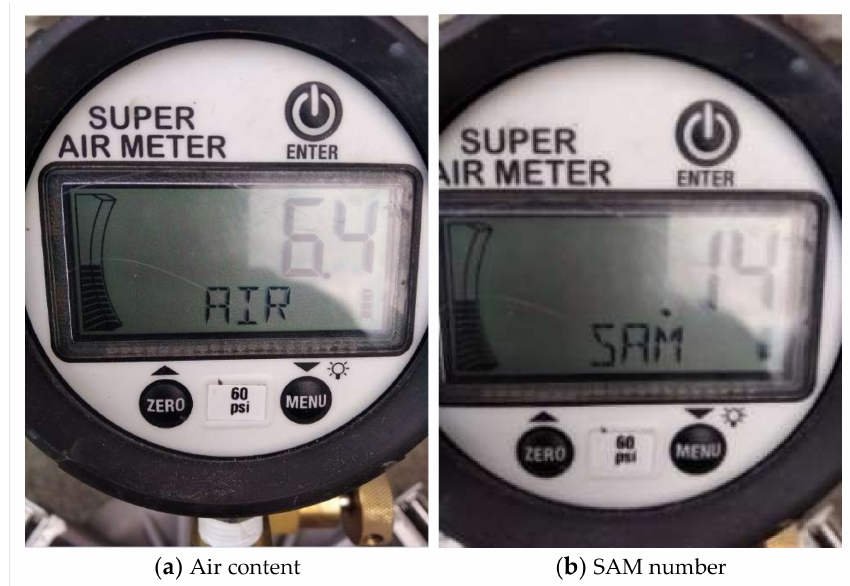
Figure 2. SAM test results ( a ) Air content ( b ) SAM